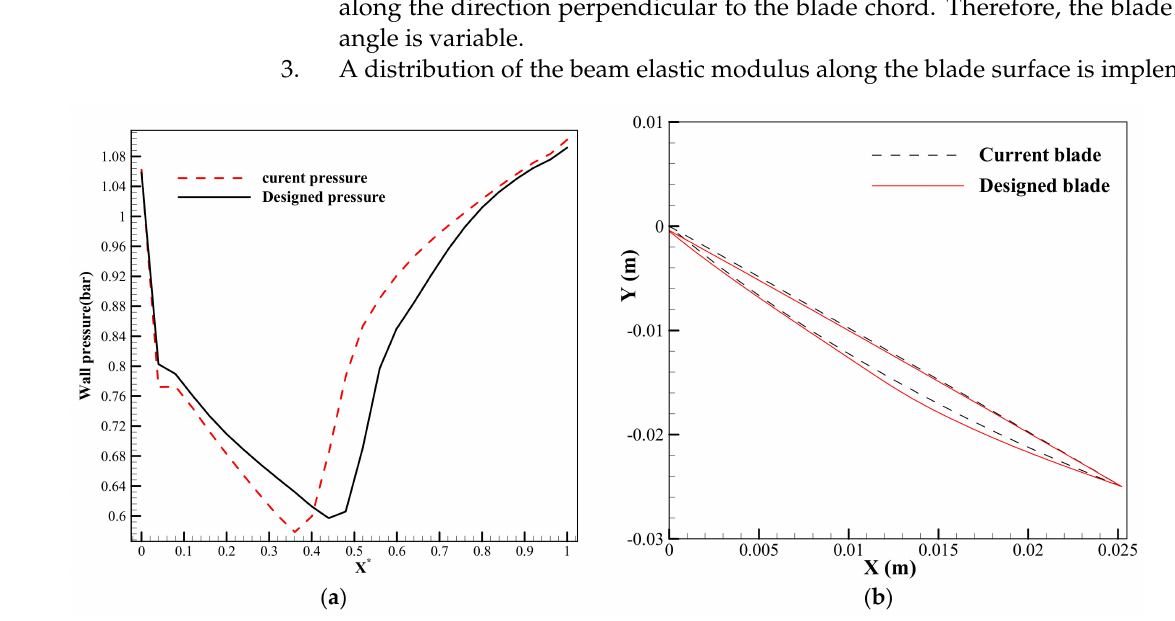
Figure 20. Third design case by UESA, ( a ) Current and target (design) pressure distributions versus non-dimensionalized X*—coordinate, ( b ) Current and designed blade geometry.